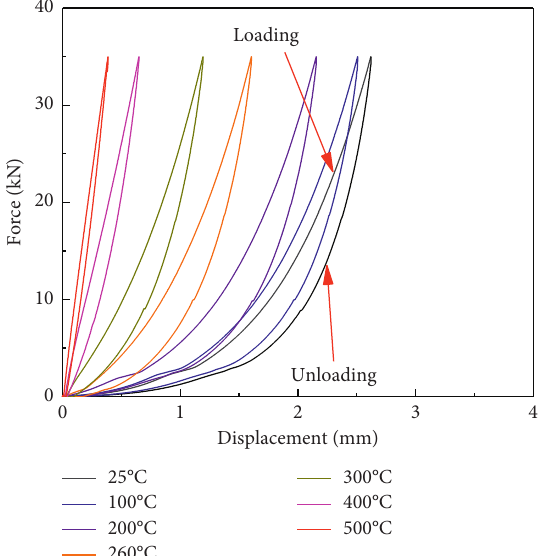
Figure 11: Force-displacement curves of EMWM under different ambient temperature.